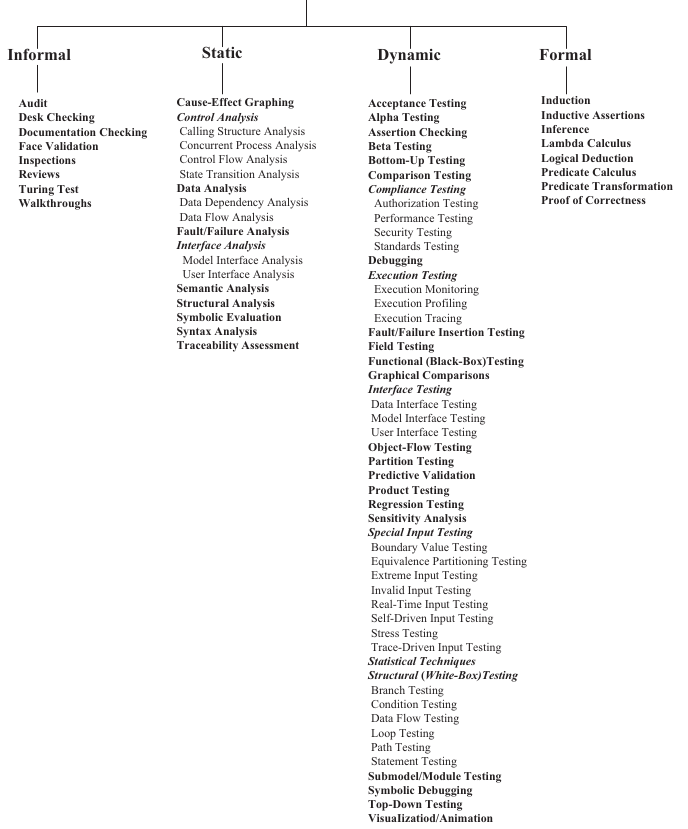
Figure 7. A taxonomy of techniques for conventional simulation